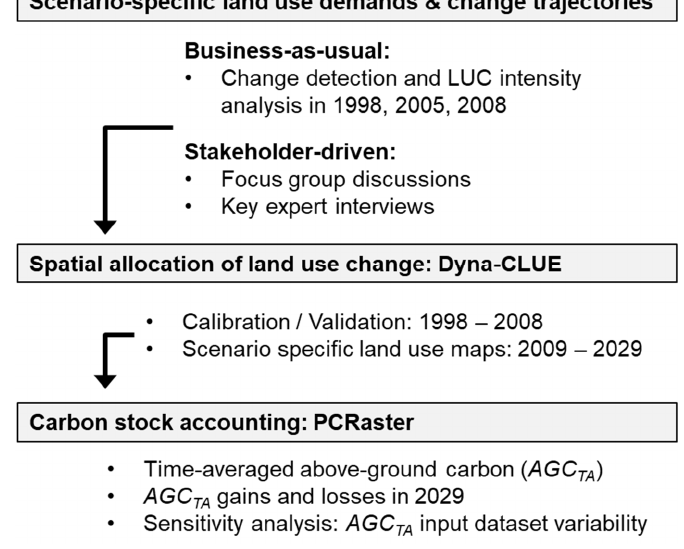
Figure 2. Conceptual study framework.